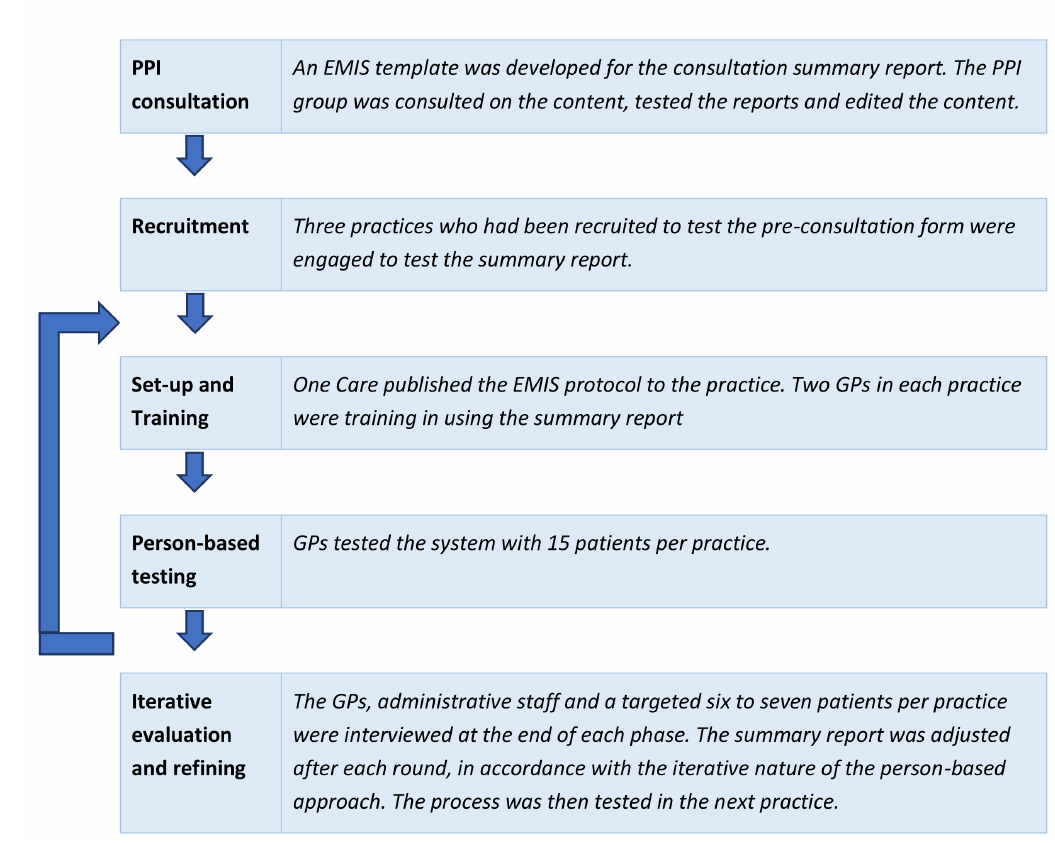
Figure 2. Person-based approach taken to develop the summary